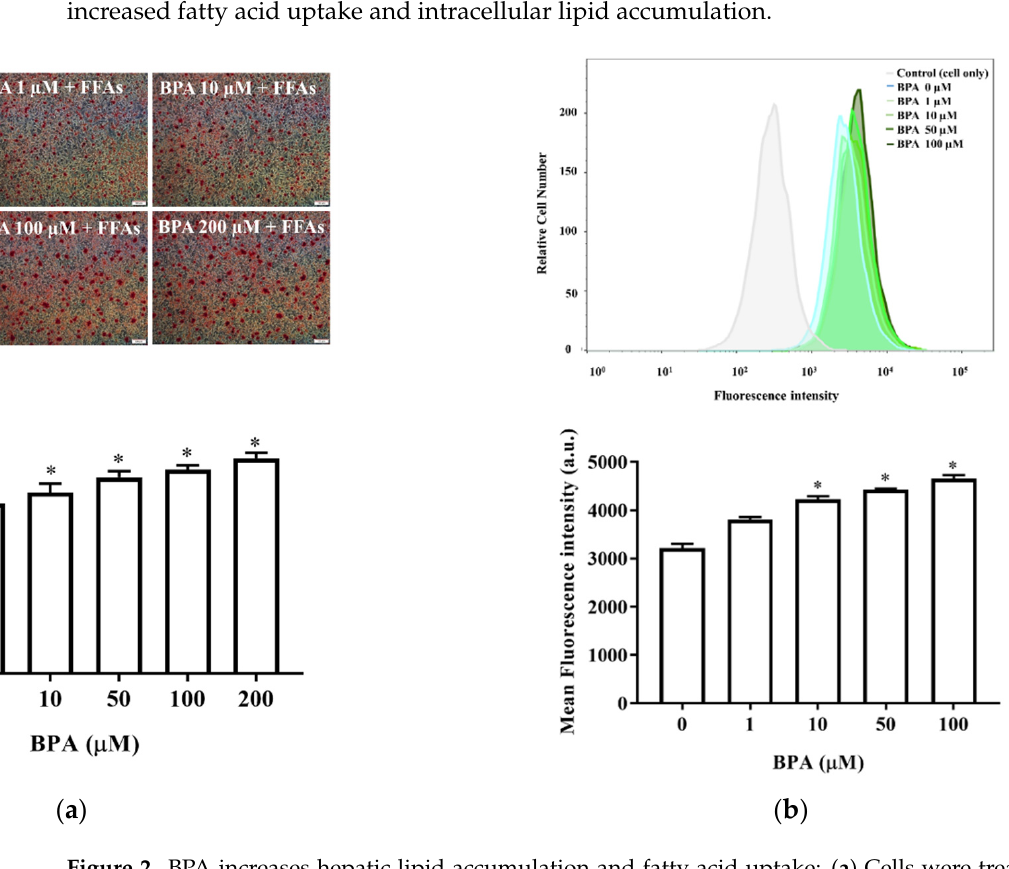
Figure 1. BPA-induced cytotoxicity and ROS production: ( a ) Cells were incubated at different con- centrations of BPA for 24 h. Cell viability was measured using an MTT assay; ( b ) cells were pre-